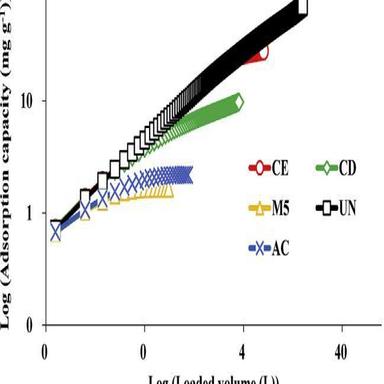
Adsorption capacities of the tested adsorbents toward high FA concentrations (5–25 ppm) (ambient temperature and 2 mg adsorbents).